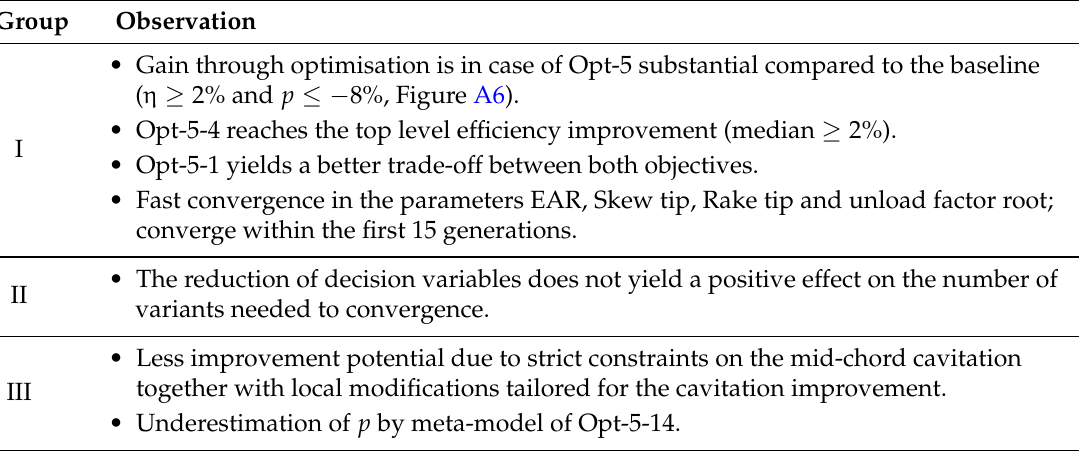
Table 14. Potential improvement and convergence observations of